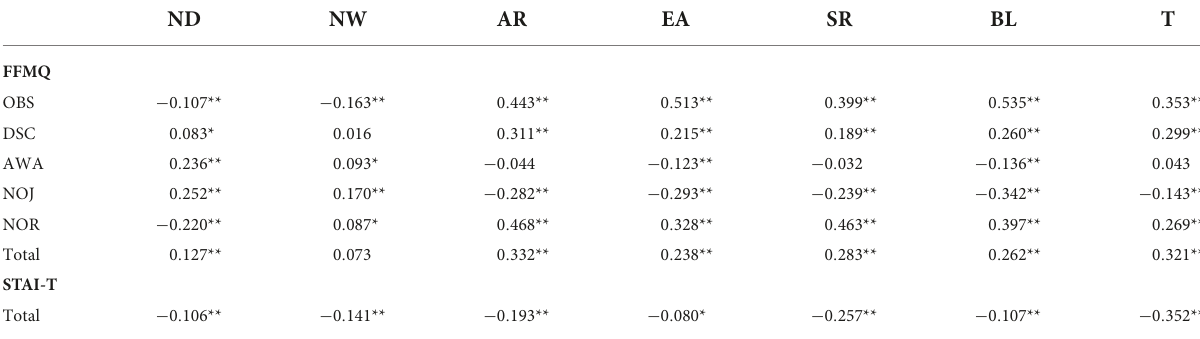
TABLE 2 Pearson’s correlations of the five-facet mindfulness questionnaire (FFMQ), state-trait anxiety inventory-trait anxiety (STAI-T), and multidimensional assessment of interoceptive awareness Chinese version (MAIA-2C). ND NW AR